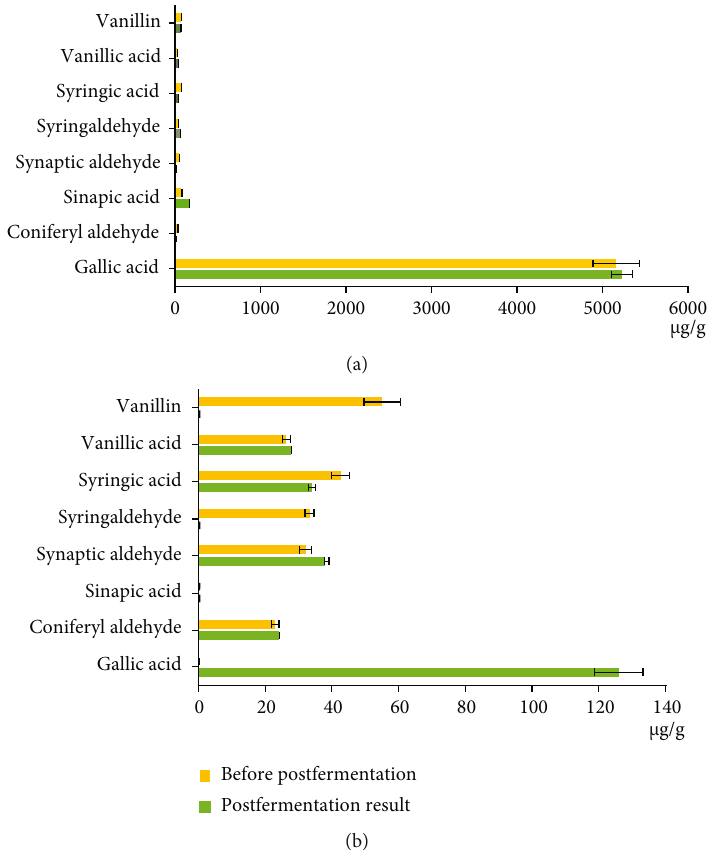
Figure 3: Impact of Eurotium cristatum INA 01267 postfermentation on the composition of phenolic compounds in herbal teas ( μ g/g). (a) Fireweed tea. (b) Apple tree leaf tea. Presented data of phenolic compound content are mean values from 3 independentextractions ± standard deviation ð SD Þ .